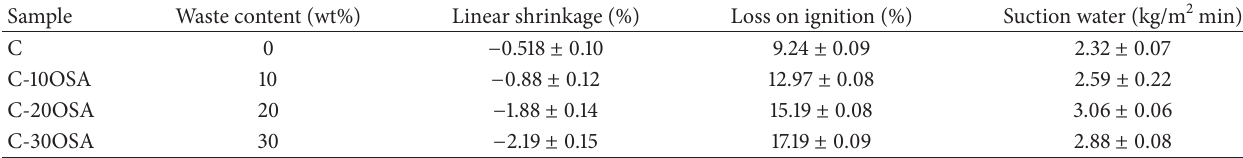
Table 3: Technological properties of fired construction bricks made from clay and olive stone ash.